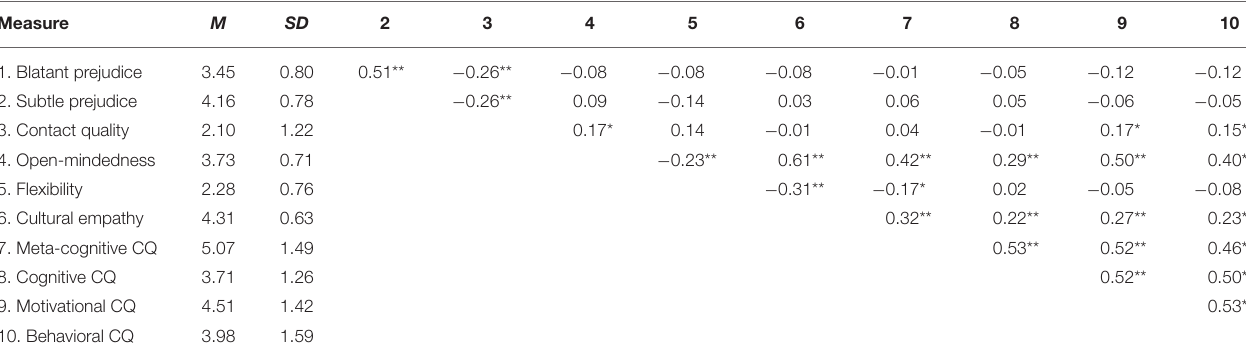
TABLE 4A | Hungarian sample: means, standard deviations, and intercorrelations for the main variables. Measure